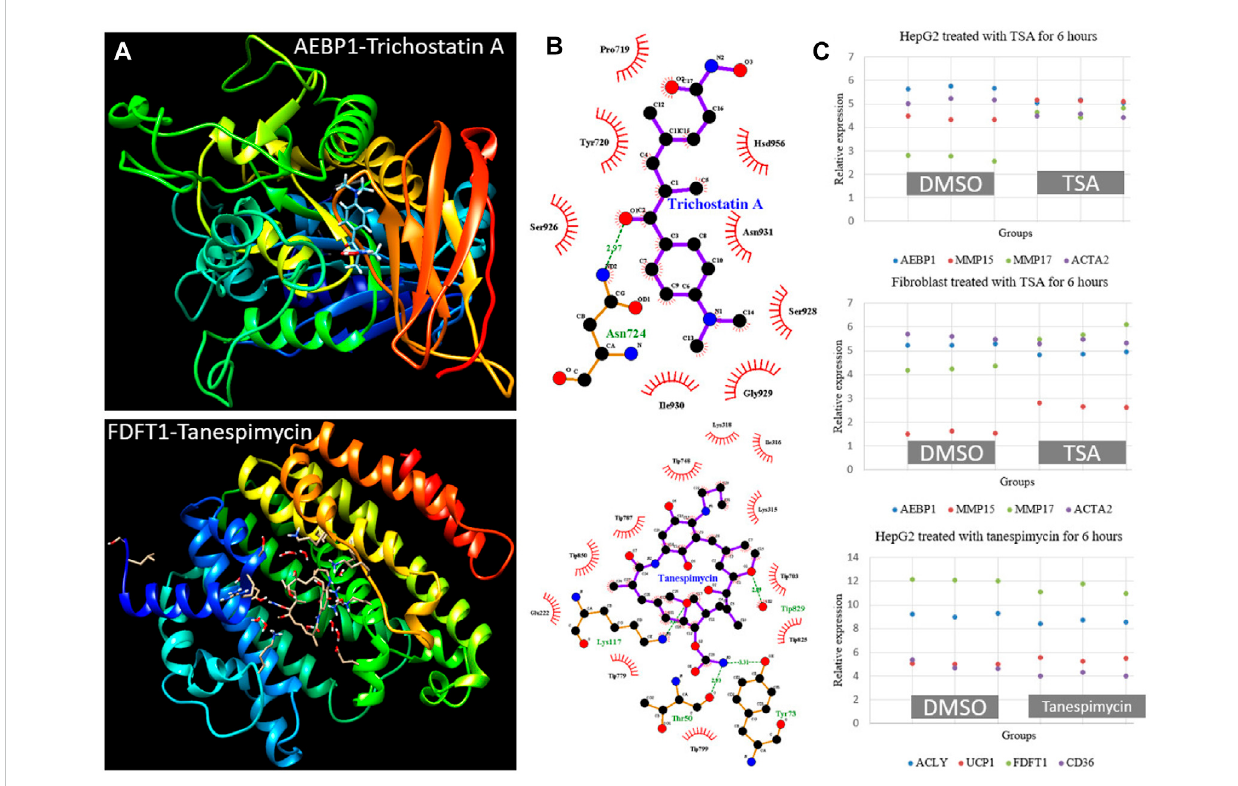
FIGURE 9 Protein-ligand docking analysis and expression validation for hub genes AEBP1 in M25 and FDFT1 in M39. (A) 3-D structure models for AEBP1- Trichostatin A and FDFT1-Tanespimycin (B) Pose view for the interaction sites. The hydrogen bonds were visualized in the green dashed line (C) AEBP1 and fi brosis-related genes MMP15, MMP17, and ACTA2 expression changed after TSA treatment in HepG2 and fi broblast cell lines from dataset GSE200186. FDFT1 and lipid metabolism-related genes ACLY, UCP1, and CD36 expression changed after tanespimycin treatment in HepG2 from dataset GSE119281. All the gene expression was detected with three replicates and had a p < 0.05 by Student ’ s